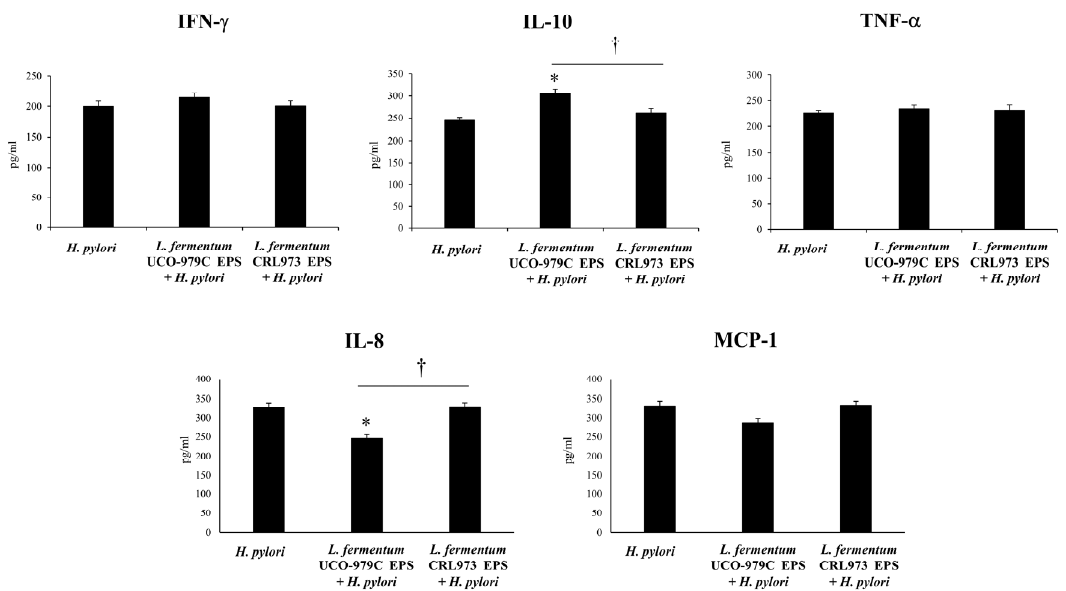
Figure 11. Effect of L. fermentum UCO-979C or L. fermentum CRL973 EPS on gastric cytokines and chemokines in adult immunocompetent mice infected with H. pylori SS1. L. fermentum UCO-979C or L. fermentum CRL973 EPS were administered to different groups of mice for two consecutive days at a dose of 100 μ g/mL mouse/day, then mice were challenged with H. pylori SS1. Two days post - infection, gastric concentrations of IFN- γ , IL-10, TNF- α , IL-8 and MCP-1 (pg/mL) were determined. Mice infected with H. pylori were used as controls. Results are expressed as mean ± standard deviation. Significant differences when compared to the control group: * ( p < 0.05). Significant differences when compared to the indicated group: † ( p < 0.05).